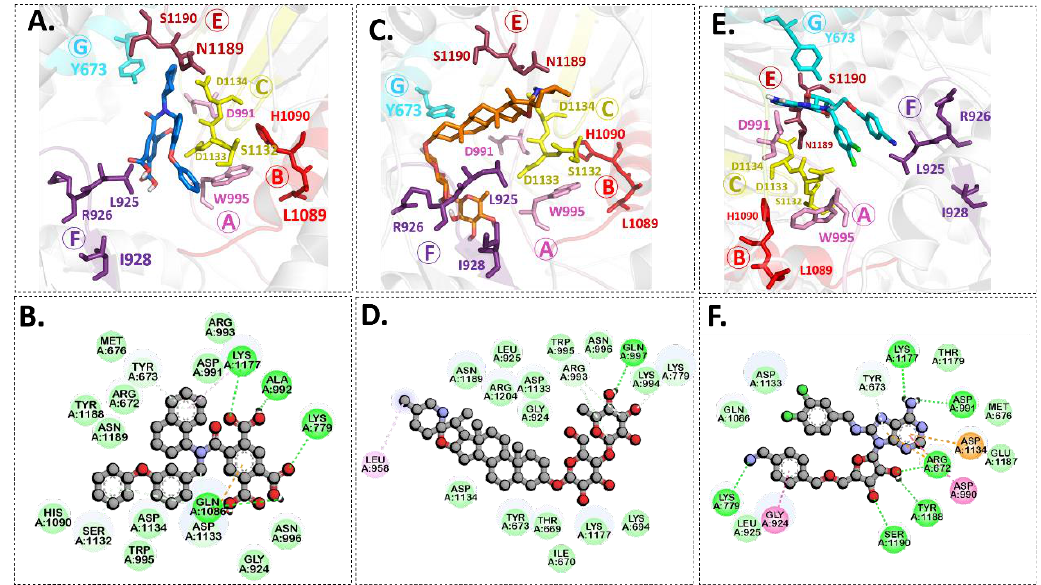
Figure 4. Binding modes and interaction mechanisms of novel L protein inhibitors. ( A ) Close-up view into binding mode of ( A ) A-317491, ( C ) Khasianine, and ( E ) VER155008. The main residues involved in the formation of the active site within the structurally conserved RdRp motifs shown in stickes. 2D interaction analysis of ( B ) A-317491, ( D ) Khasianine, and ( F ) VER155008.